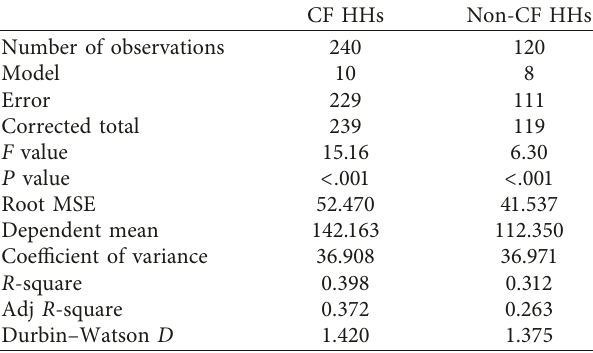
Table 9: Summary of results from statistical tests for CF and non- CF models for overall risk